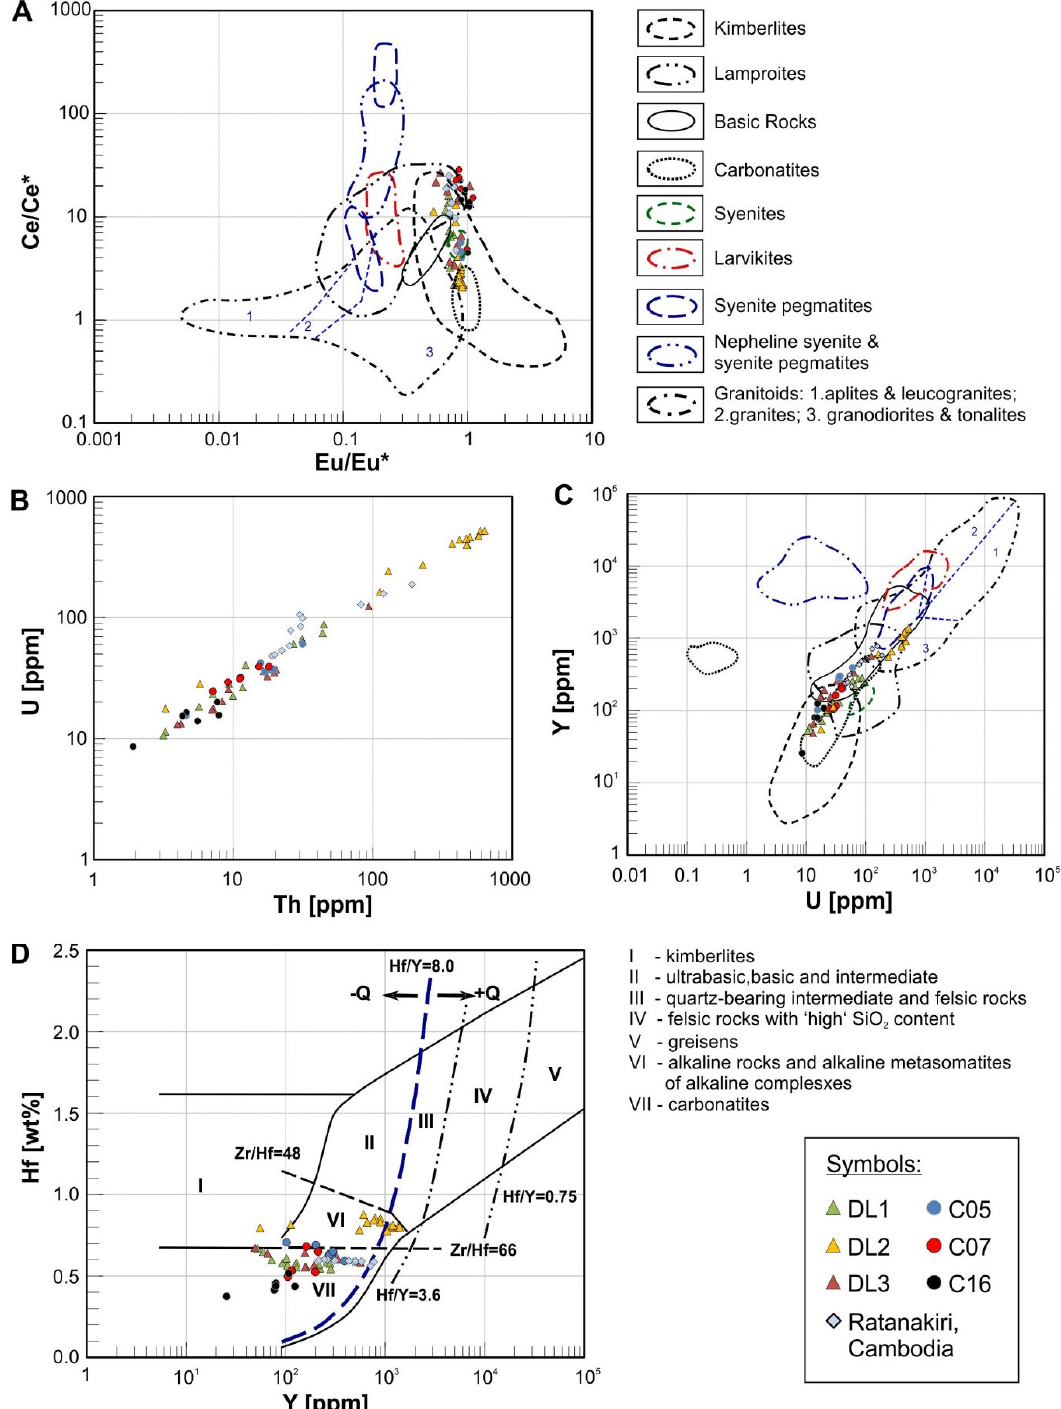
Figure 8. Compositional discrimination diagrams using trace-element concentrations of the studied samples obtained by LA-ICP-MS [16]: Ce/Ce* vs. Eu/Eu* ( A ); U vs. Th ( B ); Y vs. U ( C ); and Hf vs. Y ( D ) [41] .